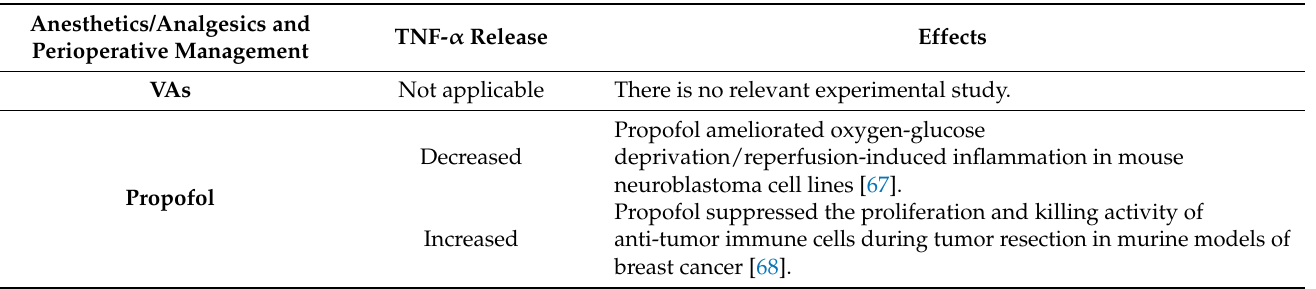
Table 1. Experimental studies on the effects of anesthetics/analgesics and perioperative care on TNF- α release and cancer cell